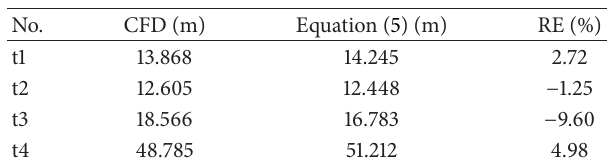
Table 5: Comparisons of 𝑆 𝑐 between CFD and (5) under